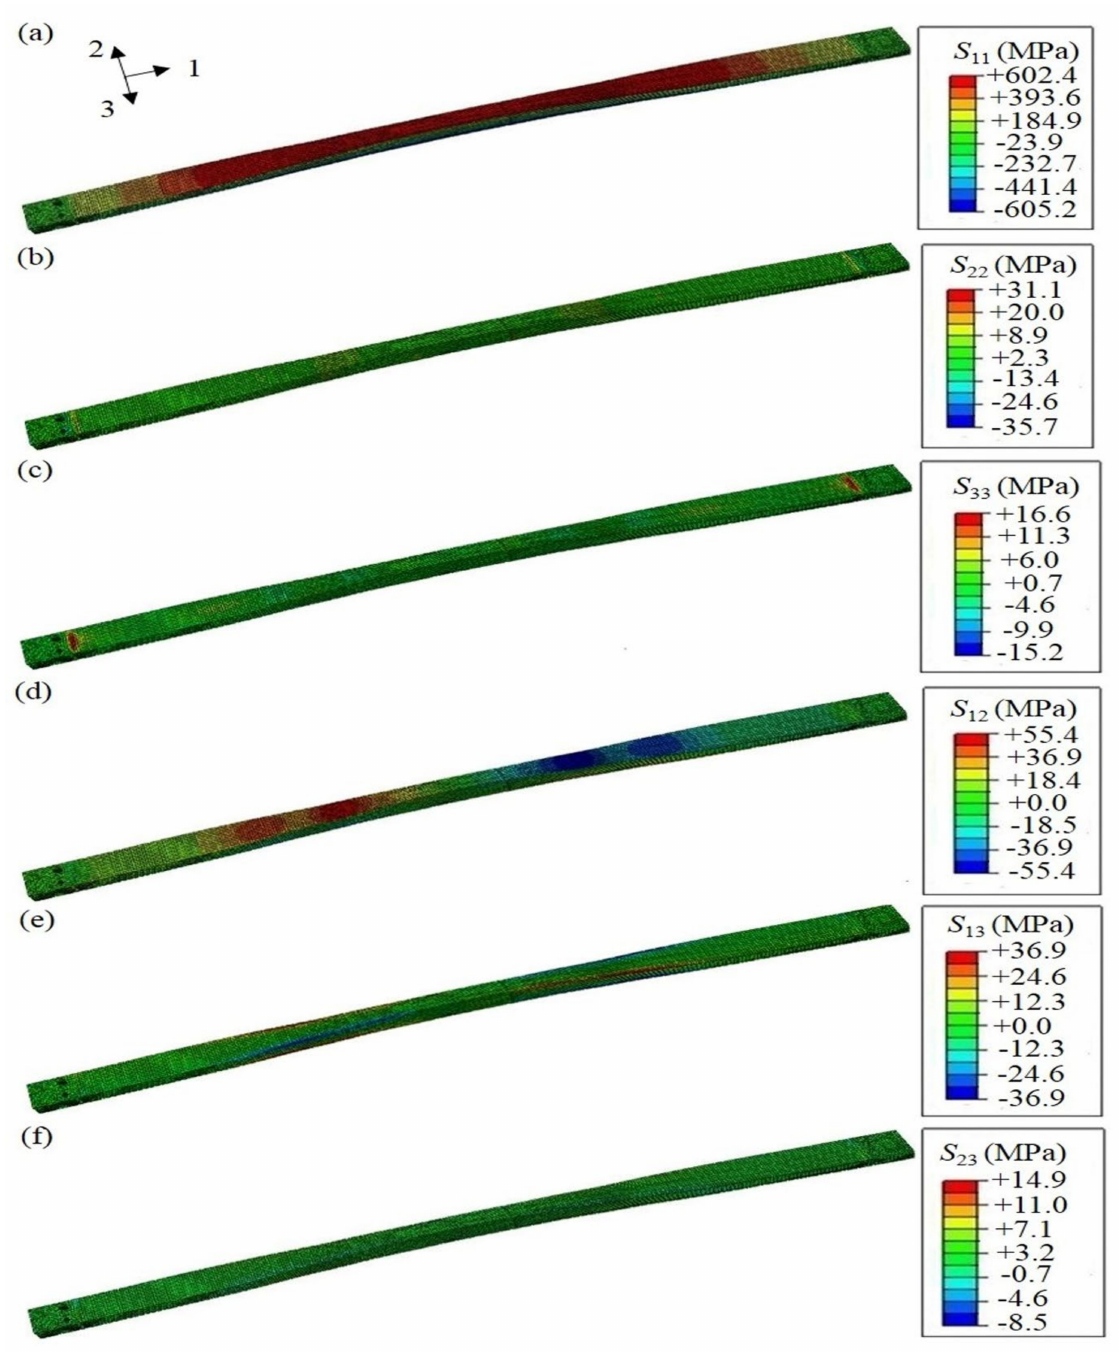
Figure 9. Stress distribution along all directions of the composite leaf spring under limit loading condition: normal stress of ( a ) length direction S 11 , ( b ) thickness direction S 22 , and ( c ) width direction S 33 ; shear stress of ( d ) length-thickness direction S 12 , ( e ) length-width direction S 13 , and ( f ) thickness-width direction S 23